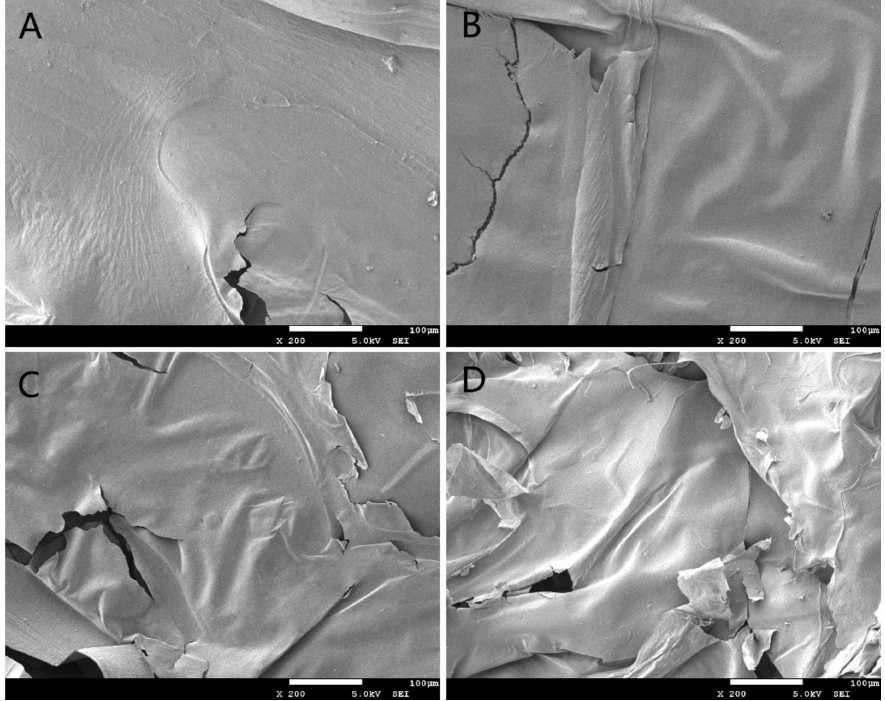
Figure 3. Photomicrograph of native APP and irradiated APP under scanning electron microscopy.